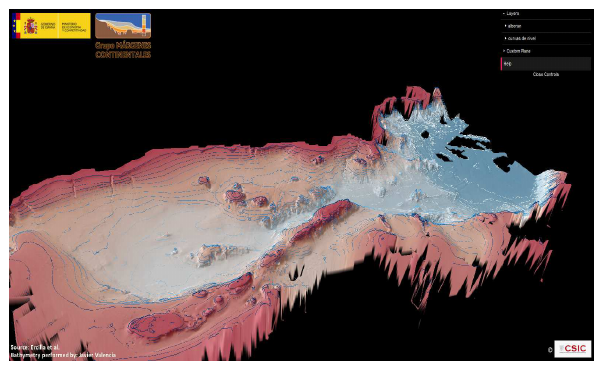
Figure 8. Prototype for bathymetry with Three.js